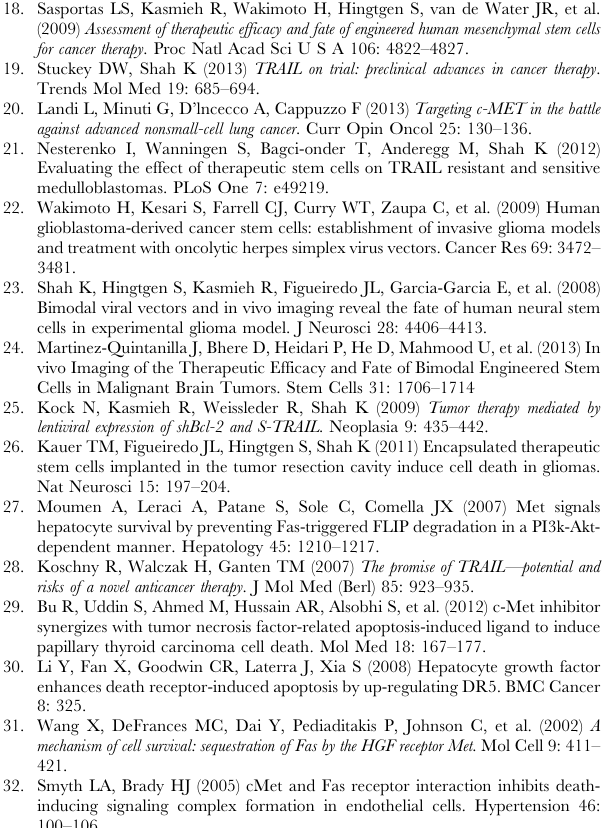
Figure S2 Characterization of modified UW473 lines. (A) Cell viability analysis showing the growth rate of both UW473scr- Fmc and UW473shMet-Fmc cells. (B) Top, representative fluorescent images of both UW473scr-Fmc and UW473shMet- Fmc cells. Bottom, plots showing the Fluc intensities of modified tumor cells with different cell numbers. (TIF) Figure S3 The c-Met protein levels in UW473 lines stably transduced with LV-scrambled or LV-shMet. Western blot analysis of c-Met and tubulin levels in UW473 cells stably transduced with LV-scrambled (UW473scr) or LV-shMet (UW473shMet).